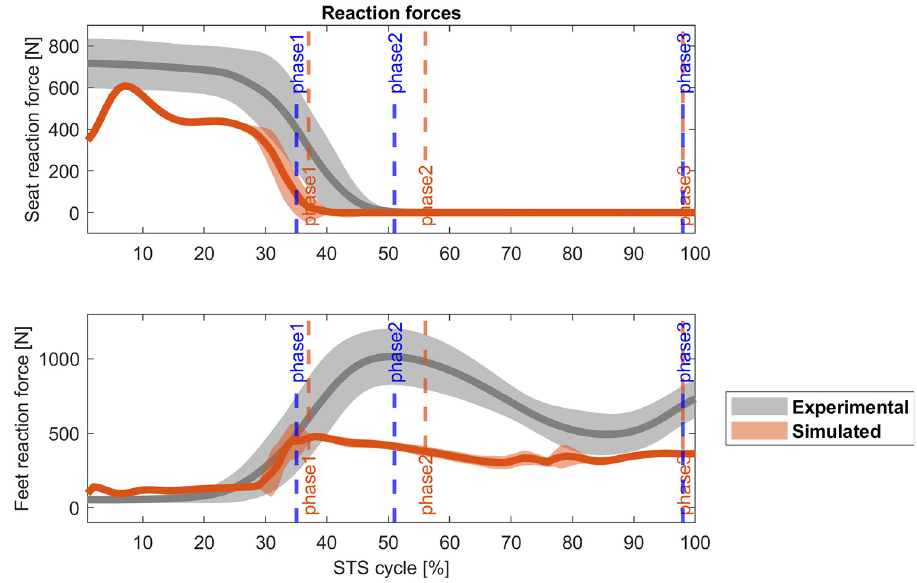
Fig 9. Comparison (mean ± std) of the reaction forces [N] for the 2-phases controller. Grey: experimental data, orange: simulated data; blue vertical lines: experimental cycle times; orange vertical lines: 2-phases controller cycle times. r Fseat = 0.96, Δ % = 0; r ground = 0.90, Δ % =